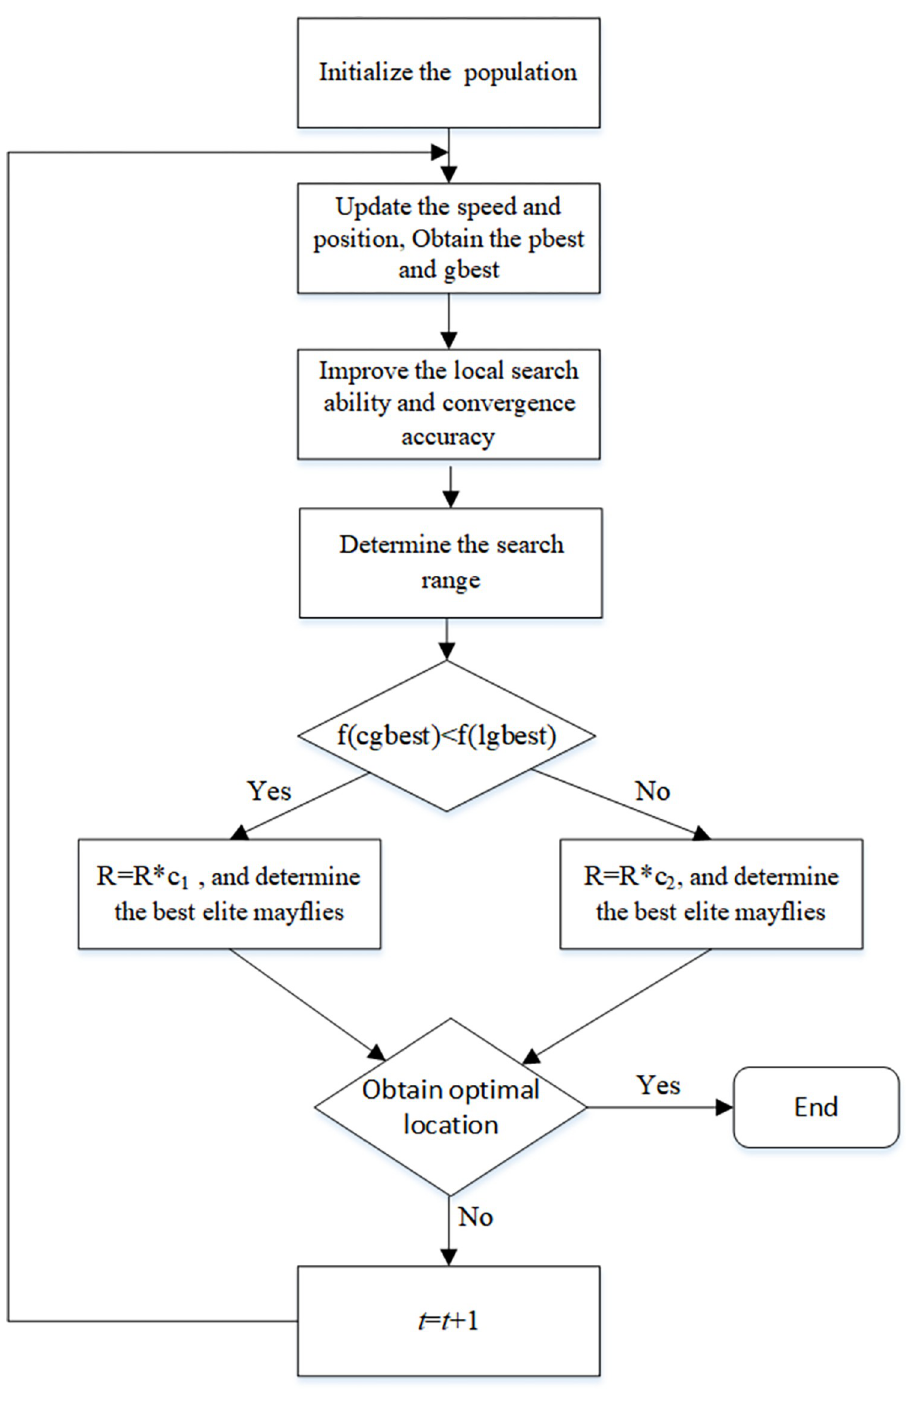
Fig 1. Flow chart of the